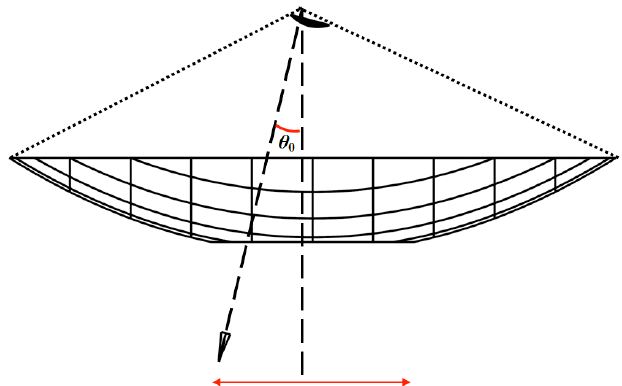
Figure 3: Optical arrangement of an off-axis Cassegrain antenna.